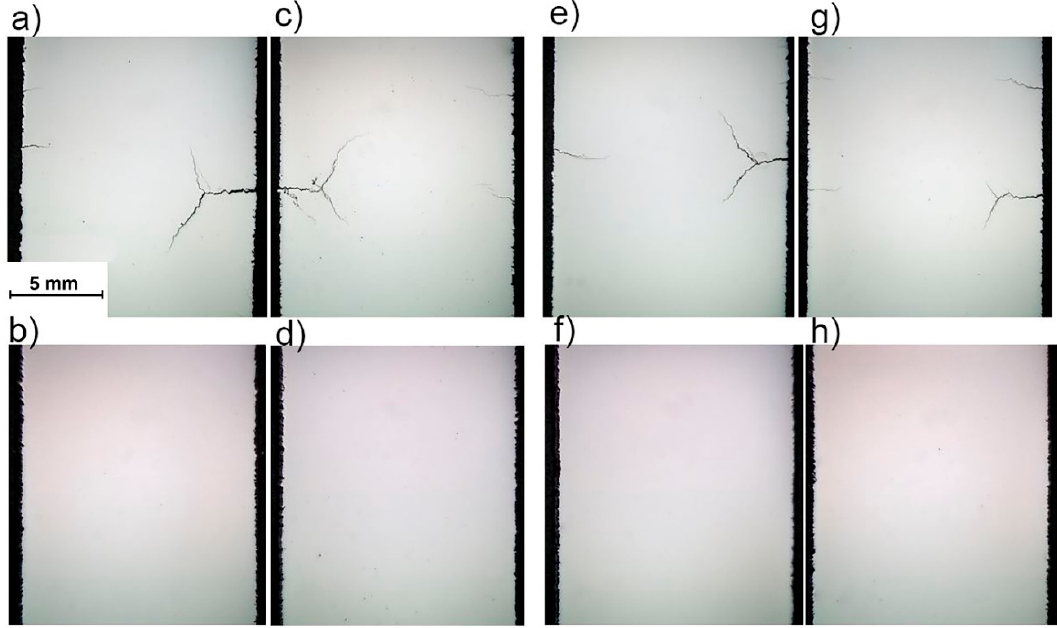
Figure 8. Effect of preheating of 200 °C on dense parts: ( a ) Sample C8; ( b ) sample PC8; ( c ) sample C10; ( d ) sample PC10; ( e ) sample C9; ( f ) sample PC9; ( g ) sample C11; and ( h ) sample PC11.